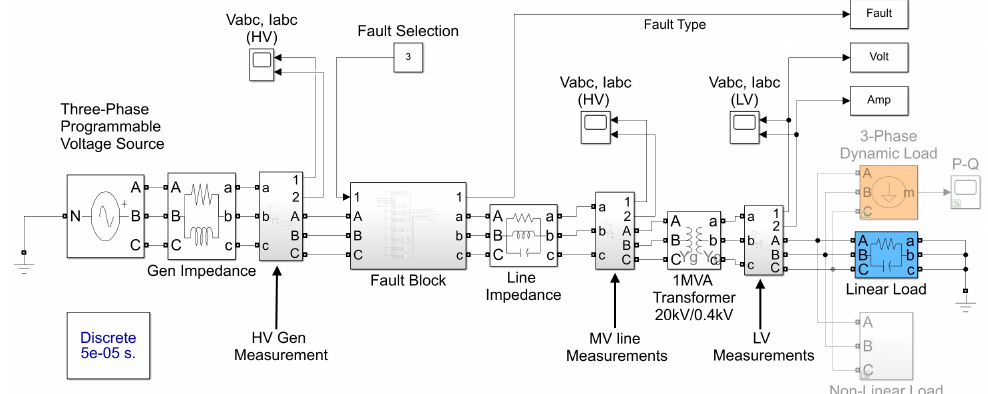
Figure A1. Simulink